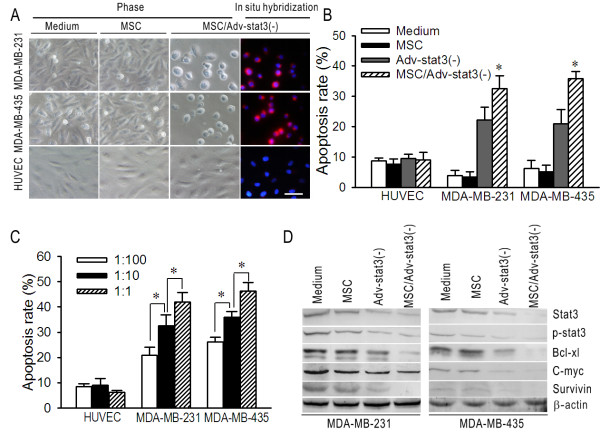
MSC/Adv-Stat3(-) selectively exerts in vitro oncolytic effects on breast cancer and melanoma cell lines and suppresses the Stat3 pathway. (A) Cytopathic effects and virus replication induced by MSC and MSC/Adv-Stat3(-) in MDA-MB-231, MDA-MB-435, and HUVEC cells. 1 × 105 MDA-MB-231, MDA-MB-435, and HUVEC cells were plated in the lower chambers of transwell plates. 1 × 104 MSCs pre-infected with 500 MOI Adv-Stat3(-) for 48 hours or MSCs alone were added in the upper chambers. Phase contrast images of the cells in the lower chamber were taken after 72 hours and in situ hybridizations targeting viral fiber were performed. Scale bar = 10 μm. Cell nucleuses were counterstained with DAPI. (B) Apoptosis rates caused by MSC, Adv-Stat3(-), and MSC/Adv-Stat3(-) in MDA-MB-231, MDA-MB-435, and HUVEC cells. 1 × 105 MDA-MB-231, MDA-MB-435, and HUVEC cells were plated in the lower chambers of transwell plates. 1 × 104 MSCs pre-infected with 500 MOI Adv-Stat3(-) for 48 hours, equivalent Adv-Stat3(-), or MSCs were added in the upper chambers. The cells in the lower chambers were stained with Annexin-V/PI after 72 hours and analyzed by FACS. (C) Apoptosis in the lower chambers in response to different ratios of MSC/Adv-Stat3(-). (D) Representative Western blot demonstrating the changes in Stat3, p-Stat3, Bcl-xl, c-myc, and Survivin caused by MSC/Adv-Stat3(-), Adv-Stat3(-), and MSC. Medium was used as a negative control. *P < .05. Results were expressed as mean ± SD in three independent experiments.